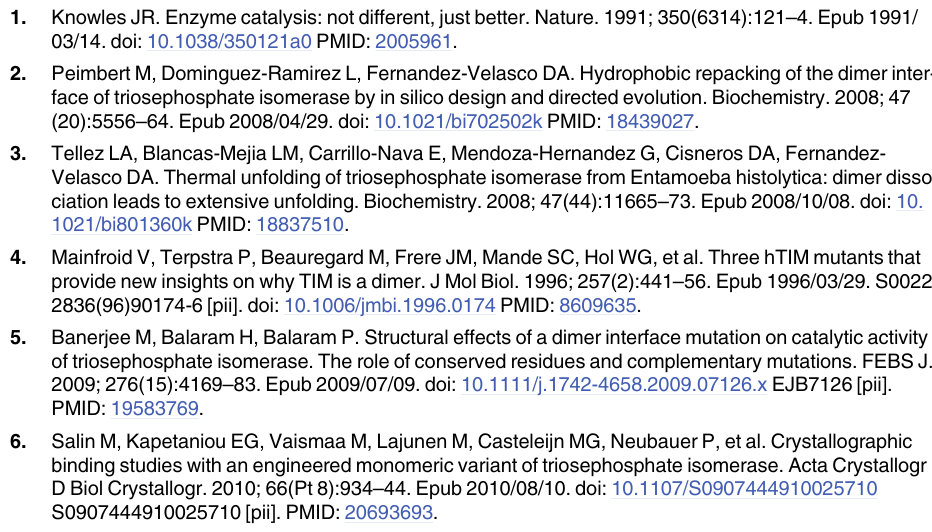
S3 Fig. Unfolding profiles of I45A, I45V, I45L, I45F, and I45Y mutants monitored by Intrinsic (black squares) and ANS (red circles) fluorescence. The conditions are as described for Fig 4. The protein concentration was 50 μ g ml-1. Data are normalized for ease of compari- son. (TIF) S4 Fig. Ile45Tyr mutant produces a disorder loop3. Crystal structure of dimeric I45Y mutant. Residues Y45 are colored in red and magenta in each subunit. α 3 and 4 present increased B-factors and are colored in yellow and orange. The loop 3 of each subunit shows a break in electron density from residues F66 to F73. S1 Table. Data collection and refinement